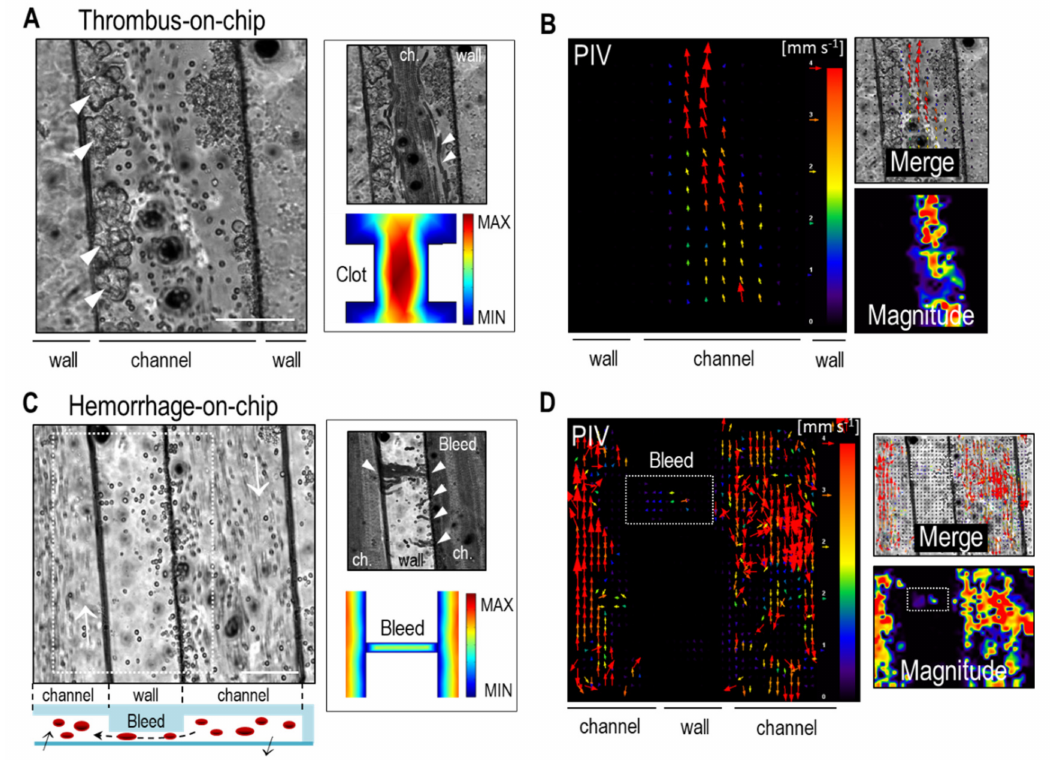
Figure 4. Thrombus and hemorrhage formation. ( A ) (Left) Thrombus-on-a-chip: formation of blood clots (white arrowheads) on the fibronectin-coated channel walls (Movie S3). (Right) Temporal projection and fluid flow simulation of RBCs circulation across a thrombi region. White arrowheads highlight the acceleration/deceleration of RBCs. ( B ) The generated constriction increased the flow velocity of RBCs as demonstrated by the micro-PIV analysis (vectorial image, merge, and magnitude measurement). ( C ) (Left) Hemorrhage-on-a-chip: formation of a leaky vessel mimicking vascular tumor-related bleeding from detached—void—PDMS wall regions and transit towards the adjacent channel. (Right) Temporal projection showing the bleeding regions and trajectories of the RBCs (white arrowheads) (Movie S4). The fluid flow simulation (modelling a bleed region) shows the transit of RBCs across adjacent channels. ( D ) The micro-PIV plots show the motion of RBCs inside and outside the channel. Scale bars: 100 µ